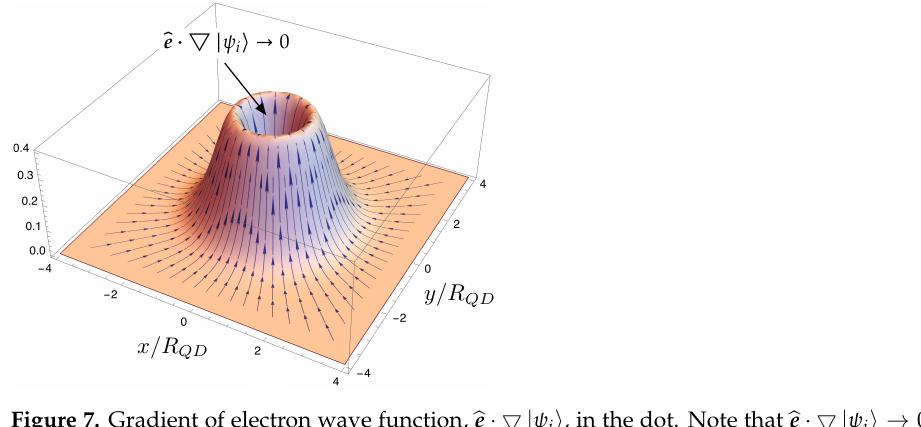
ψ i 0 when · (cid:53) | (cid:105) →